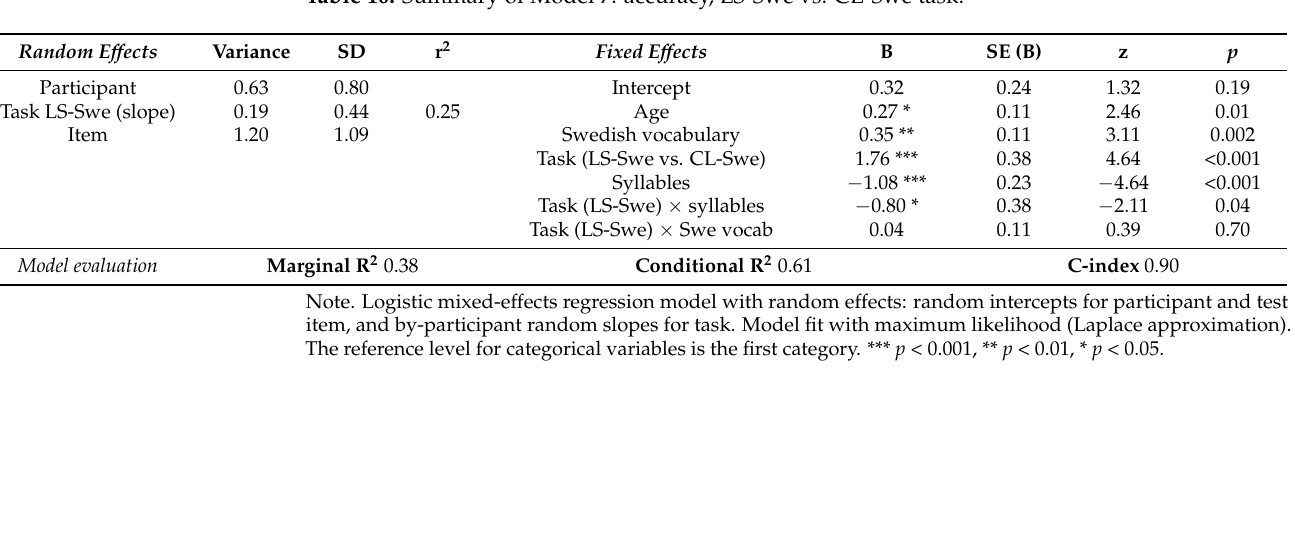
Table 10. Summary of Model 7: accuracy, LS-Swe vs. CL-Swe